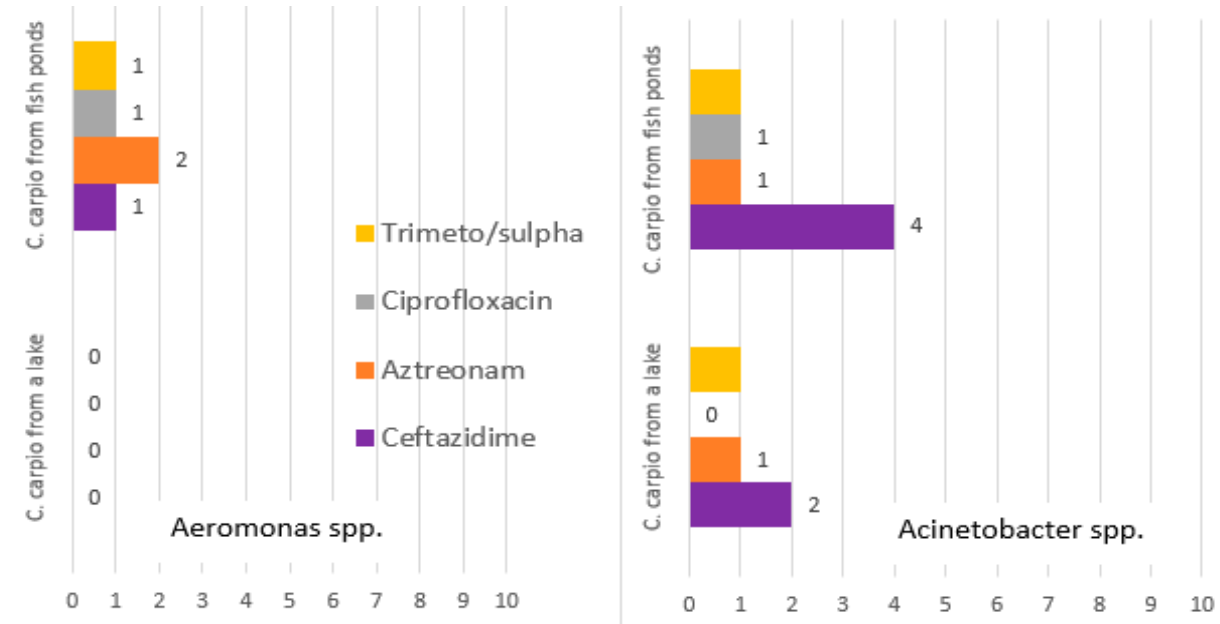
Figure 7. The number of resistant isolates of bacteria genera Aeromonas and Acinetobacter isolated from carp .